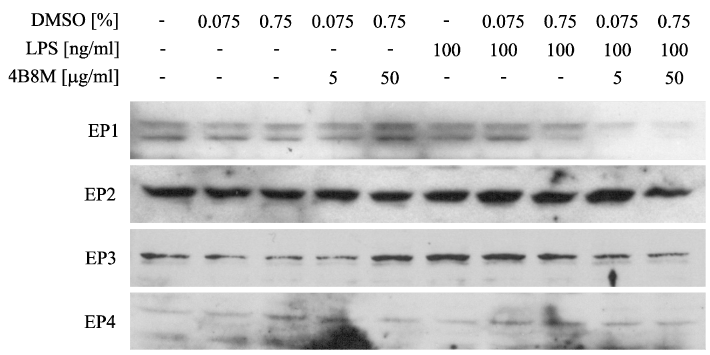
Figure 13. Effect of 4B8M on expression of ICAM-1 on human peripheral blood mononuclear cells (PBMC).